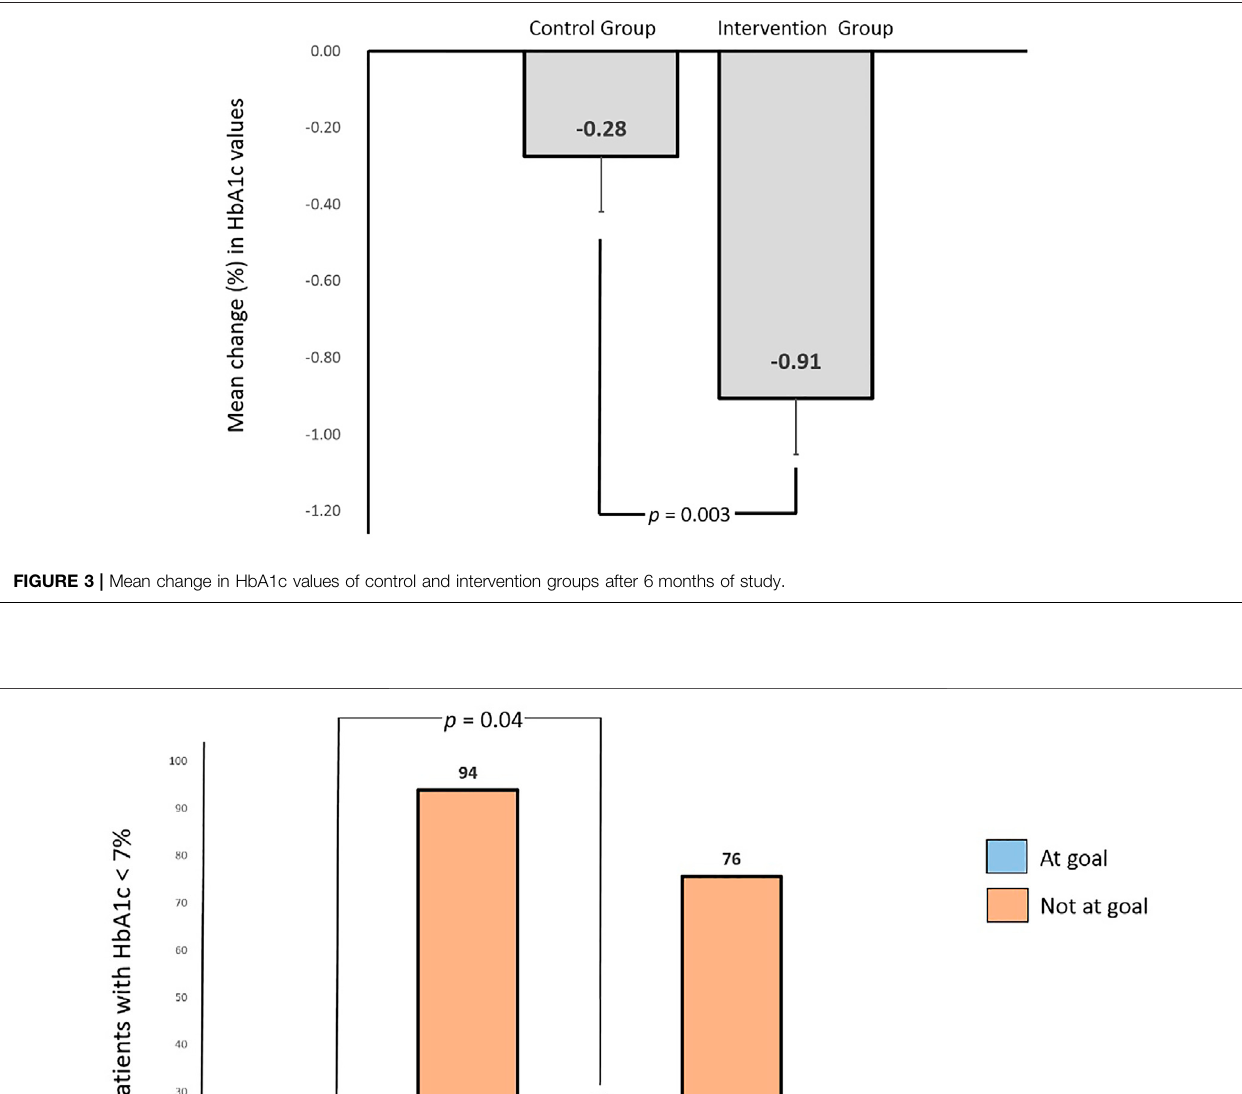
Frontiers in Pharmacology |